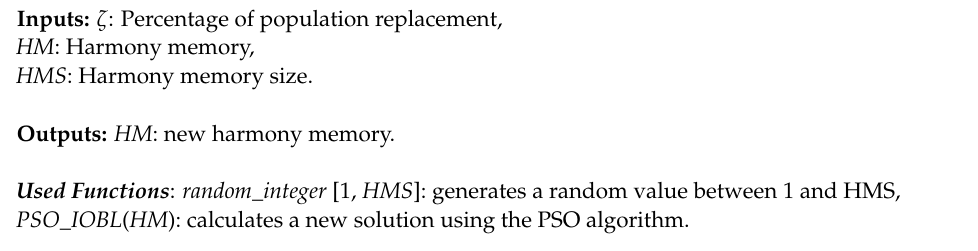
Algorithm 4 . Reinitializing Harmony Memory